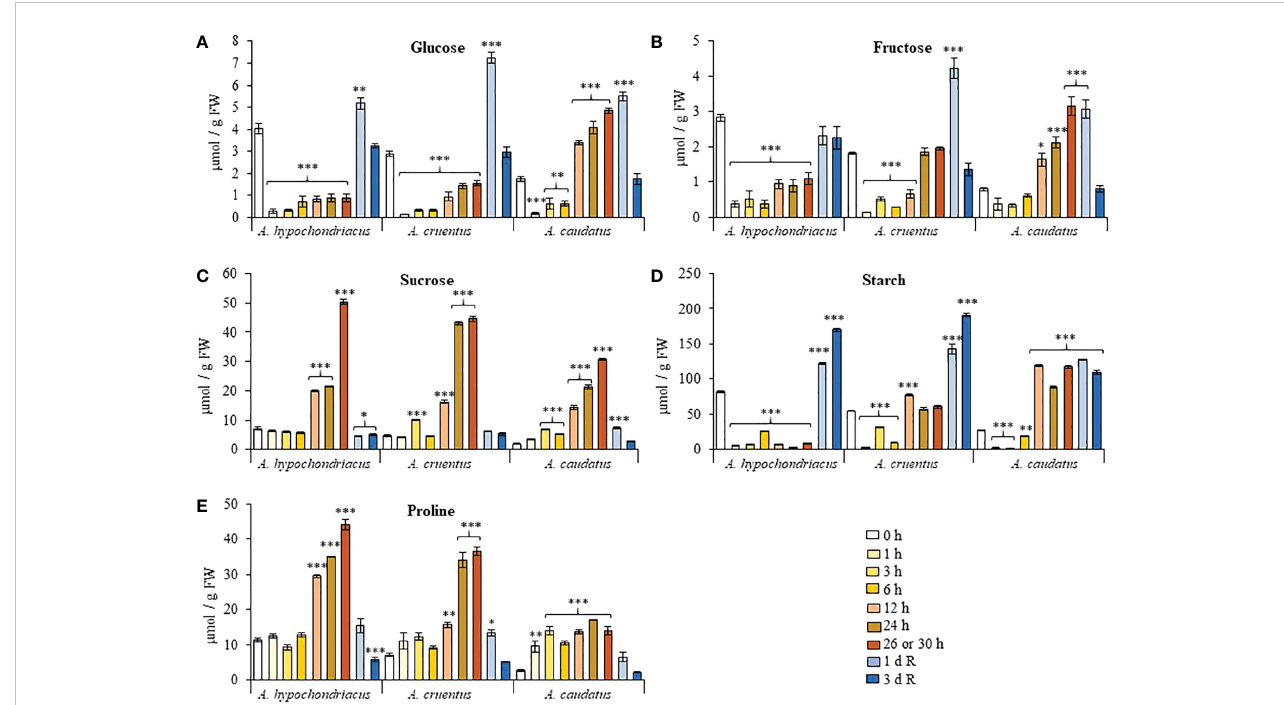
FIGURE 3 Fluctuation in the levels of non-structural carbohydrates and proline recorded during heat shock and subsequent recovery in grain amaranth plants. Changes in the levels of (A) glucose, (B) fructose, (C) sucrose, (D) starch and (E) proline detected in leaves sampled from grain amaranth plants at the V1 development stage subjected to heat shock (HS) for 0, 1,3, 6, 12, 24, 26 ( Amaranthus cruentus ) or 30 h ( A. hypochondriacus and A caudatus ) and after 1 (1 d R) and 3 (3 d R) days of recovery from HS under optimal conditions. The bars represent the mean value (n = 30) ± SE. Asterisks over the bars represent statistically signi fi cant differences within species at P ≤ 0.05 (*), P ≤ 0.01 (**) or P ≤ 0.001 (***); one-way ANOVA and Tukey Kramer